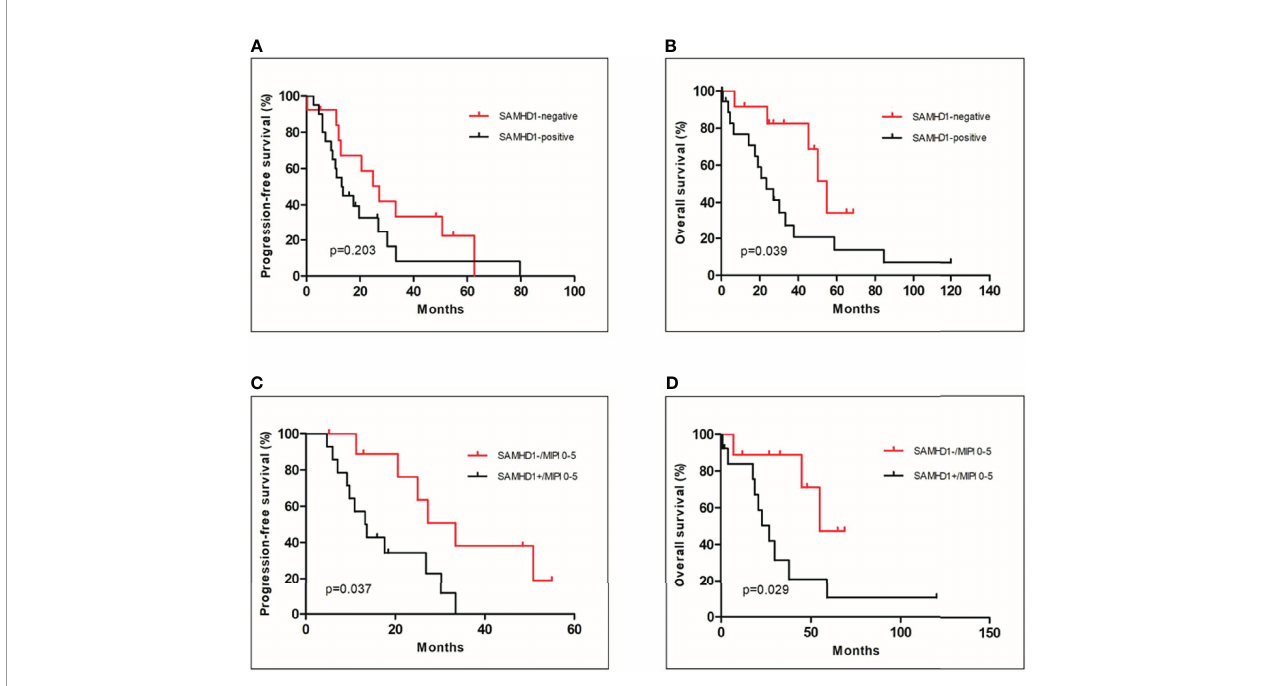
FIGURE 4 | Relationship of the SAMHD1 expression with clinical outcome of MCL patients. There was no signi fi cance in PFS between SAMHD1-positive and SAMHD1-negative patients (A) . However, SAMHD1-positive patients had shorter OS than SAMHD1-negative patients (B) . Among low- to intermediate-risk MCL patients (MIPI score between 0 and 5), SAMHD1-positive patients had worse PFS (C) and OS (D) than SAMHD1-negative